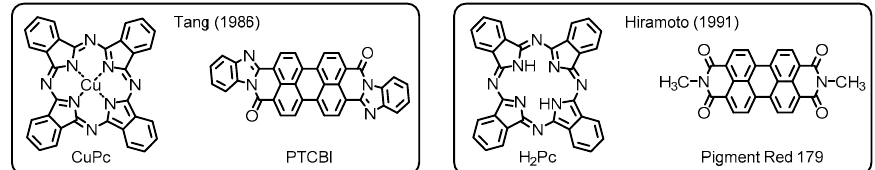
Figure 2. Chemical structures of organic semiconductor materials employed in the primitive organic photovoltaics (OPVs) developed by Tang and Hiramoto. Adapted from references [14,15].